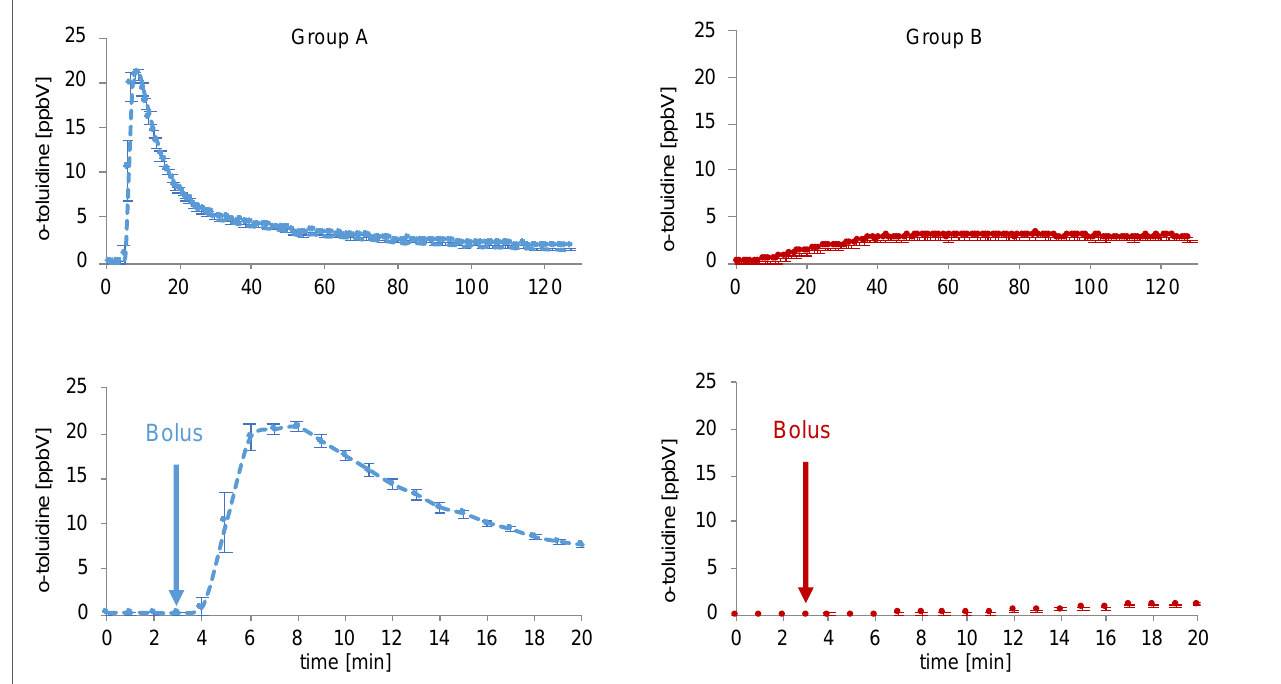
Figure 2. Continuous measurement of o-toluidine concentrations in breath by PTR-ToF-MS over 120 min (above) for two single pigs (blue line group A (intravenous injection of prilocaine), red line group B (cervical plexus regional anaesthesia with prilocaine)). Each data point represents mean concentrations over one minute. The diagrams at the bottom show the first 20 min. Bolus was administered at the third minute.